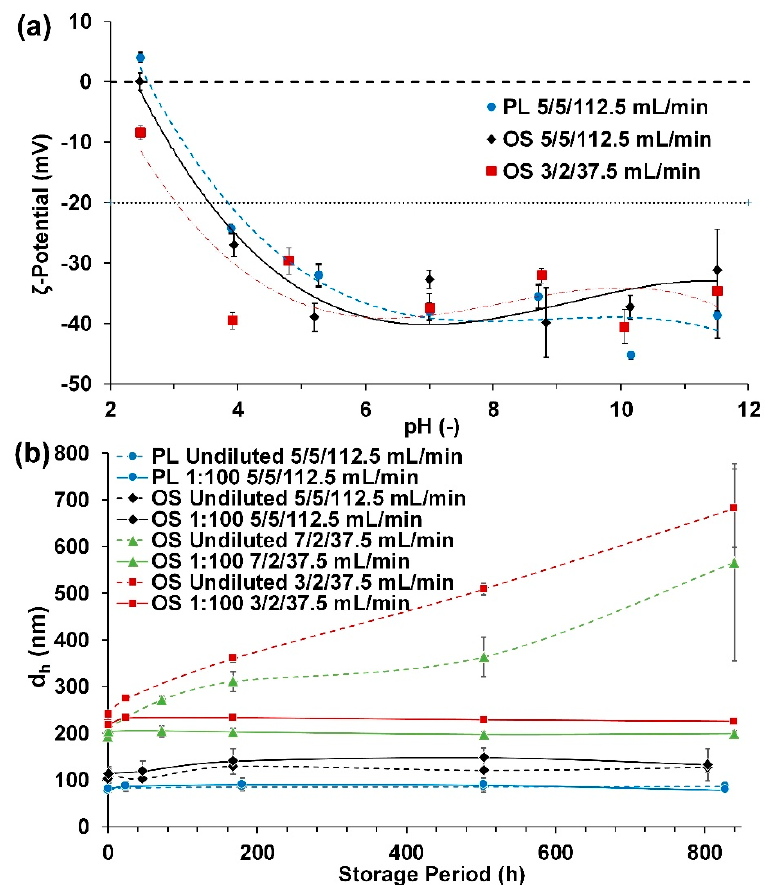
Figure 6. ( a ) ζ -potential over a pH range of 2.5 to 11.5; ( b ) long-term particle stability, where storage and precipitation parameters are labeled in following order: Type of particles (purified lignin (PL) and organosolv extract (OS)), storage condition (undiluted and 1:100 dilution), pH value, antisolvent / OSE ratio and